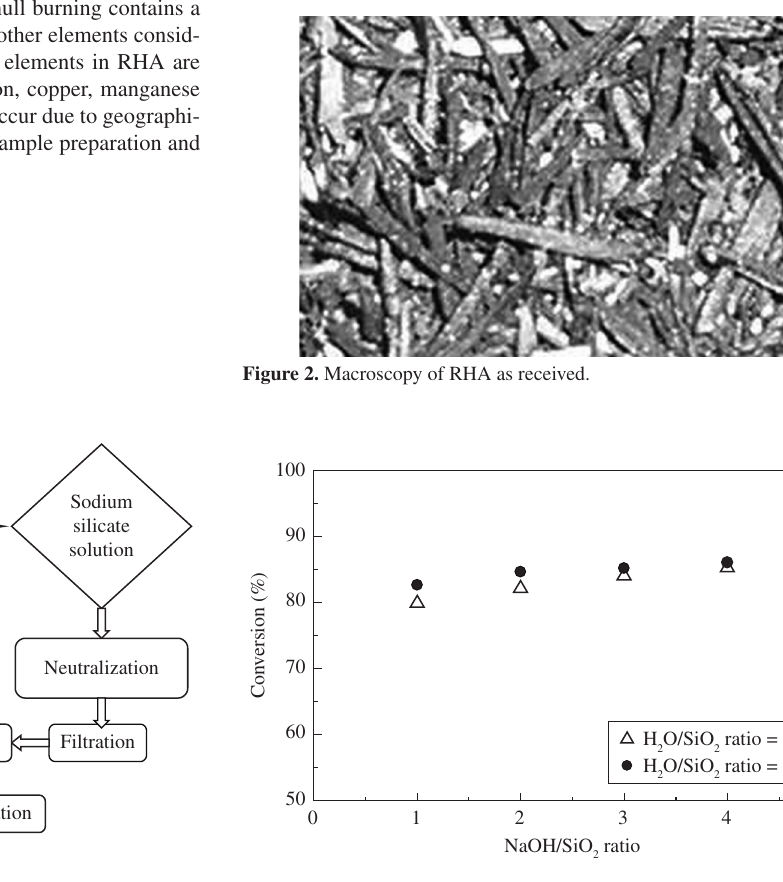
ratios = 11 and 22 (open system; 1 hour of reaction; T = 100